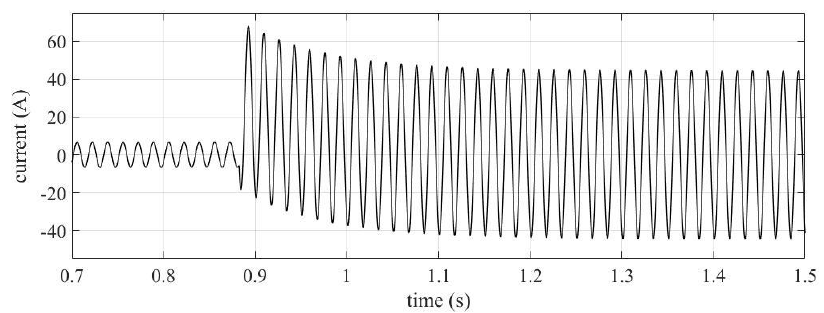
Figure 11. Three-phase fault current — phase A — without SV manipulation condition.